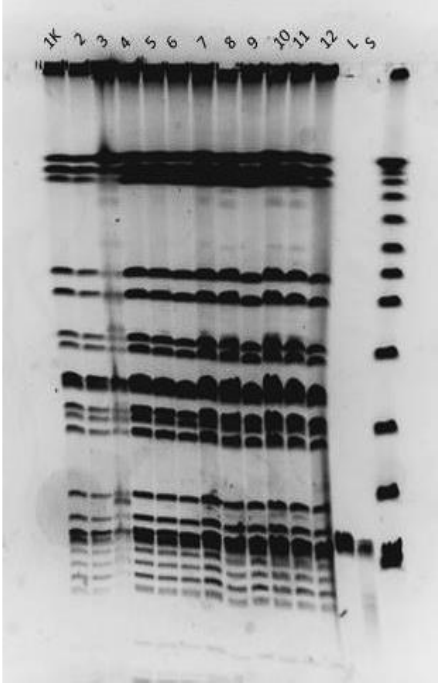
Figure 11. Pulsed-field gel electrophoresis of selected phage-resistant strains. Xba I macrorestriction pattern; ( 1K ) Ni9 parental strain ( 2 – 12 ) resistant mutants, ( L ) LASTA, ( S ) SJM3.